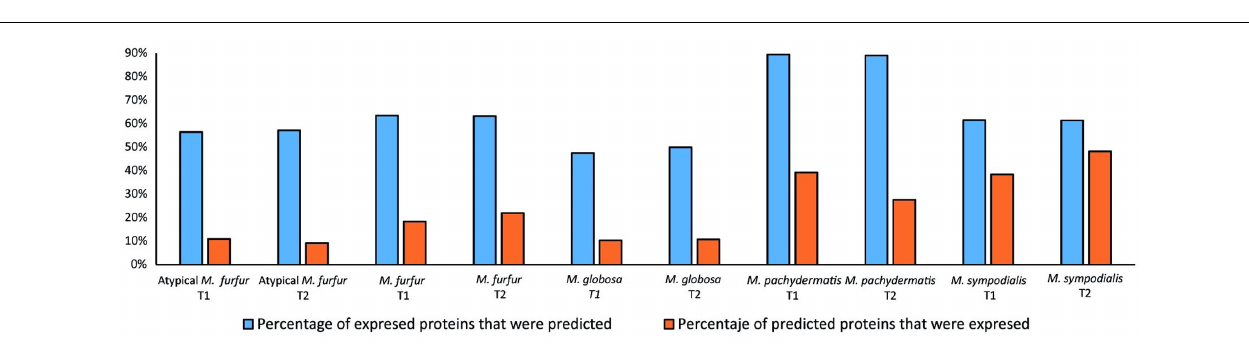
FIGURE 9 | Protein validation as the percentage of enzymes predicted by the model that were expressed and the percentage of enzymes expressed that were